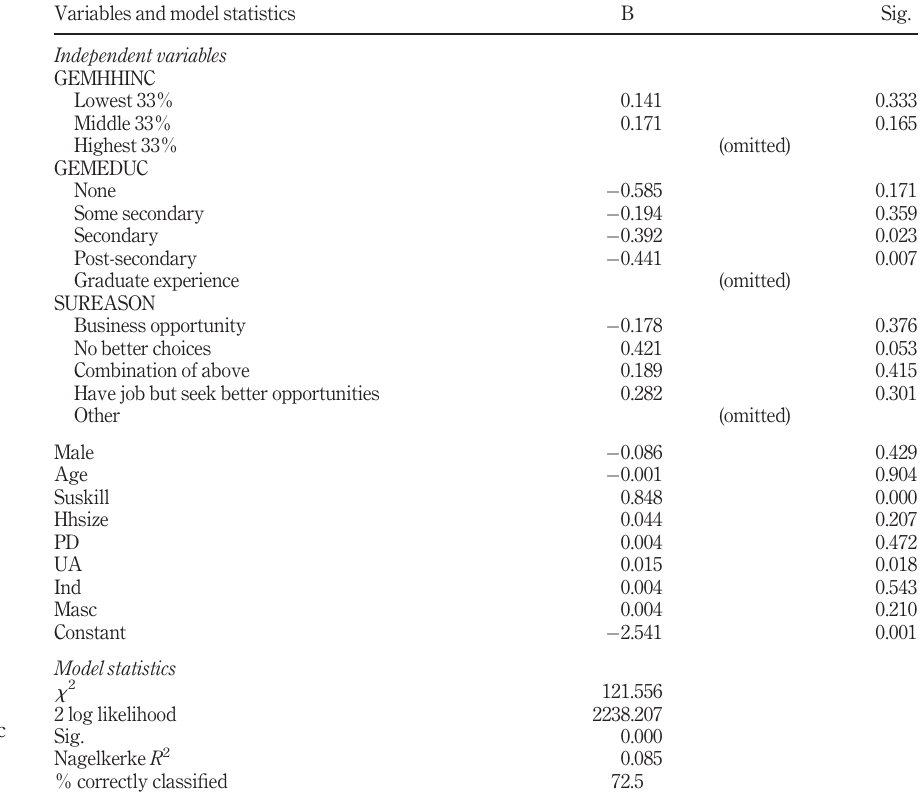
Table III. Results of